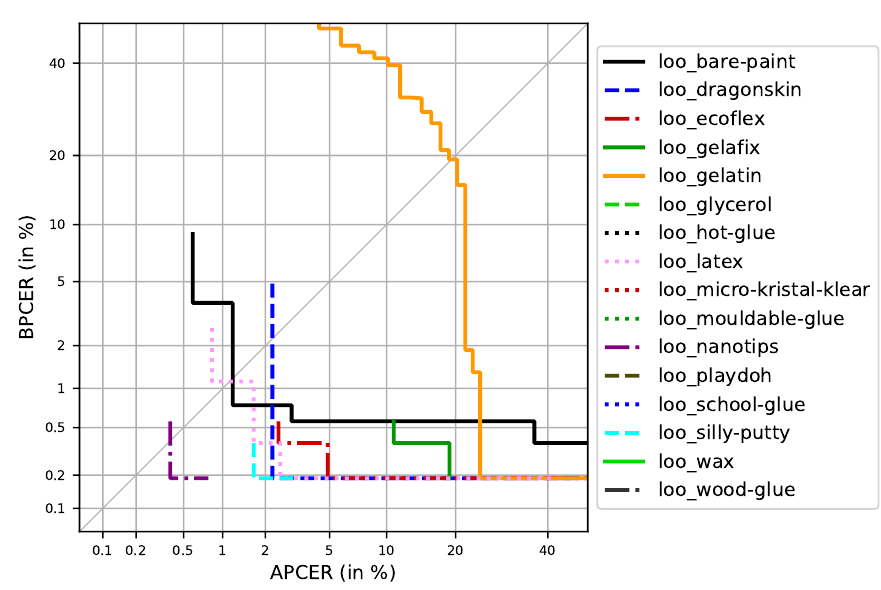
( b ) DET curves of the different LOO partitions. Perfectly classified results show no curve. Figure 6. DET plots for the different experiments: ( a ) baseline and ( b ) LOO. For the baseline partition, a D-EER of 2.45% and an APCER 0.2 of 2.89% were